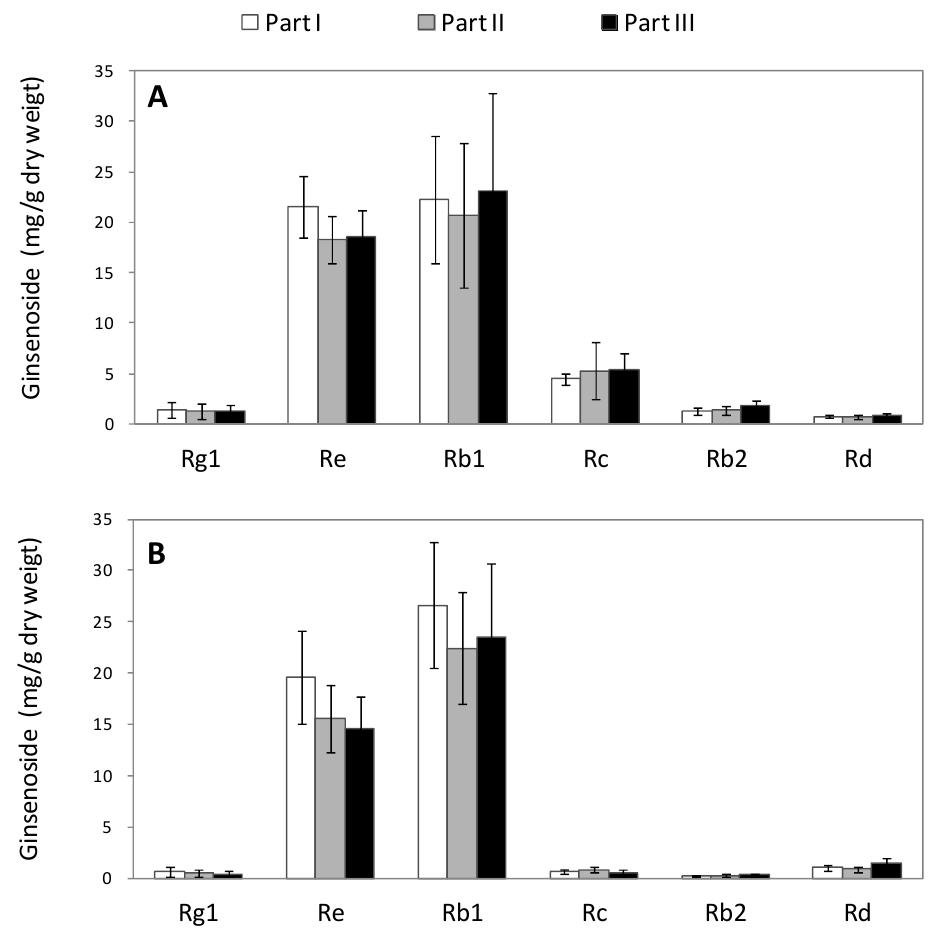
Figure 3. Measurement of ginsenoside (Rg weight) in three root parts (I, II, and III) of healthy American ginseng in: ( A ) phloem and ( B ) xylem. Mean values of ginsenoside amongst the three root parts (I, II and III) are not significantly different at α = 0.05 ( p > 0.05), analyzed using Fisher’s least significant difference (LSD)